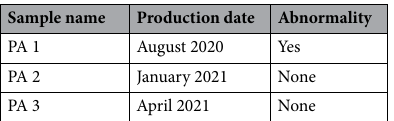
Table 1. PAs sample provided by Elantas Europe